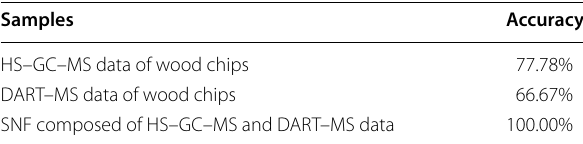
Table 1 Prediction accuracy using HS–GC–MS, DART–MS, and the SNF composed of HS–GC–MS and DART–MS data,